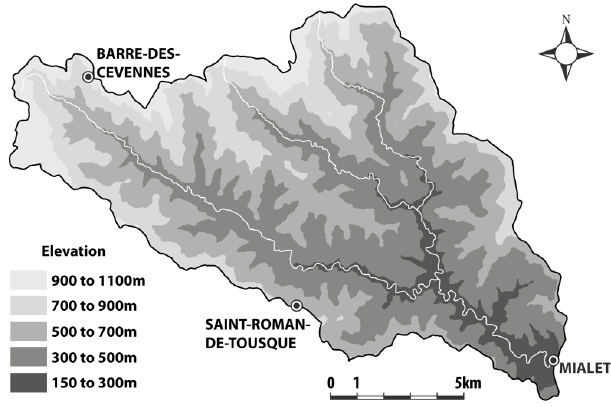
Fig. 2. Schematic topographic and hydrographic map of the Gardon-de-Mialet basin, including gauge locations (elevations de- rived from ASTER GDEM, a product of METII and